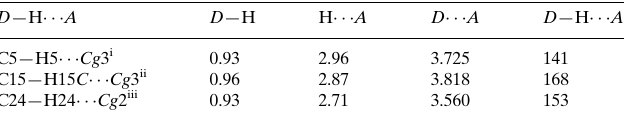
Hydrogen-bond geometry (A˚ , (cid:2)